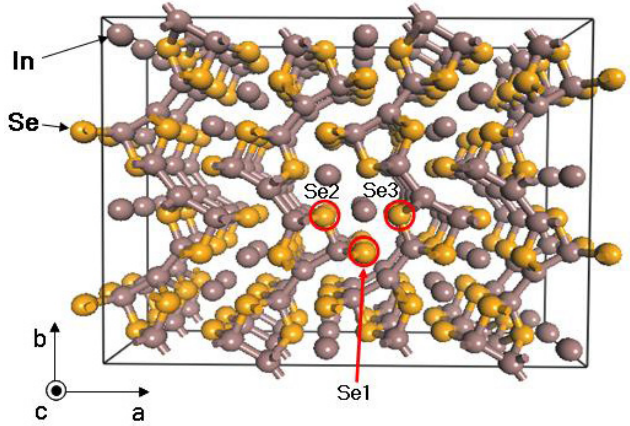
Figure 2. Crystal structure of In 4 Se 3 . Reproduced with permission from Nature publishing Group, 2009